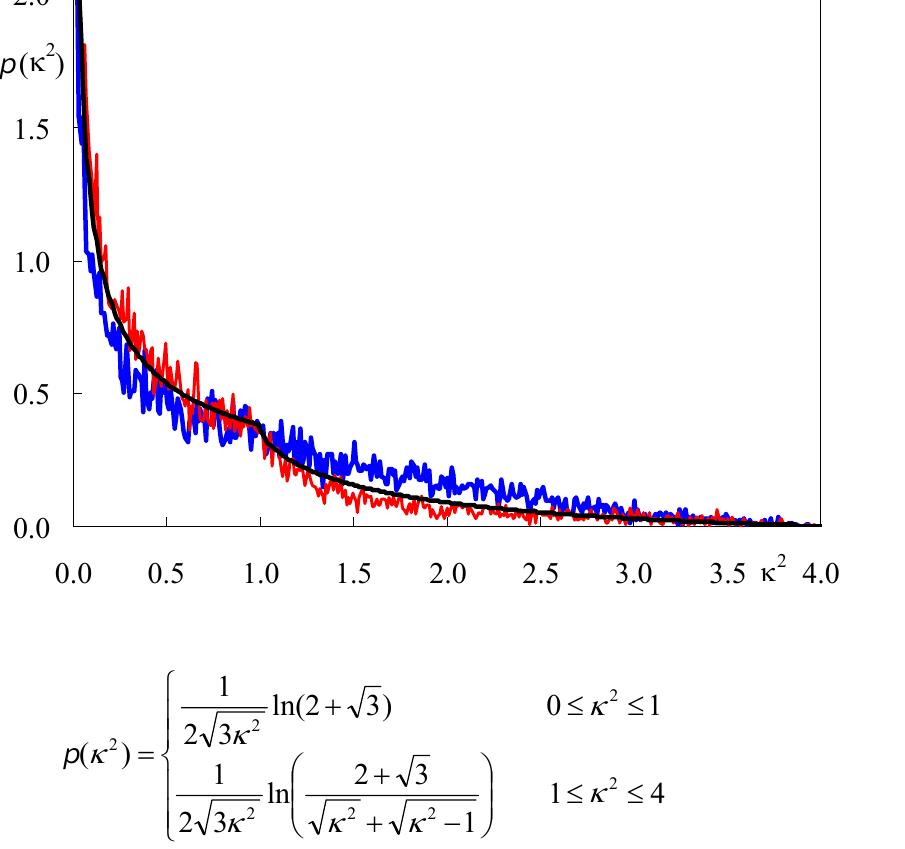
Figure 3. Calculated probability density p ( κ 2 ) for C6-NBD-PC (red) and C12-NBD-PC (blue), compared with the analytical isotropic result of Equation 2 (black). Adapted from [25].